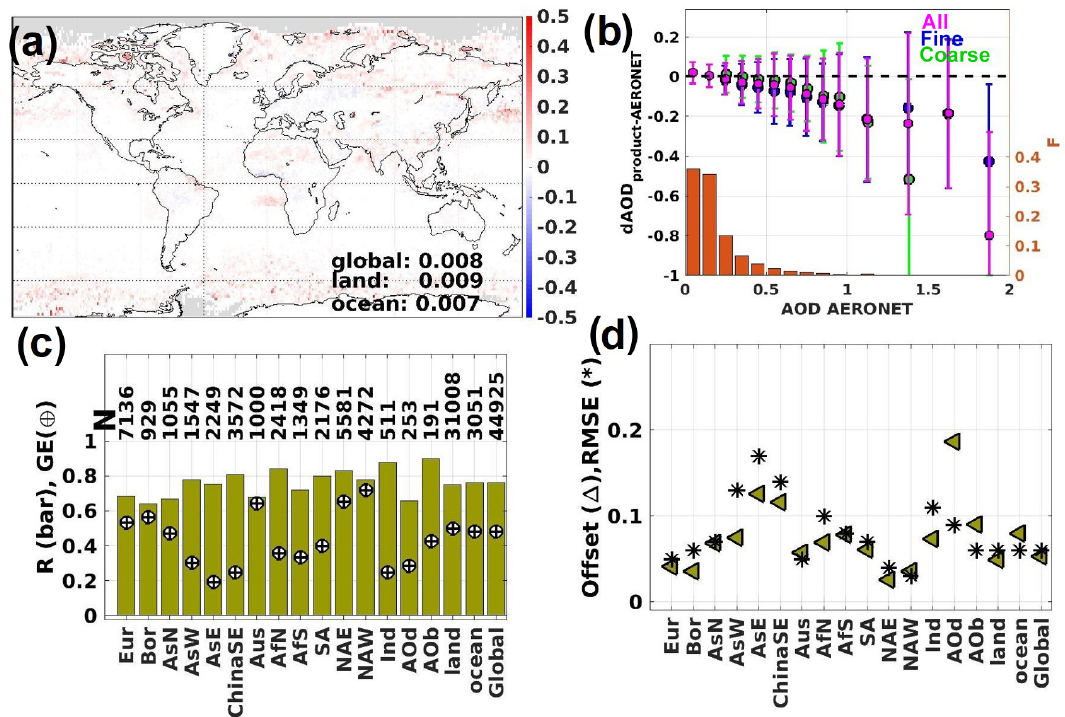
Figure 9. (a) L3 merged (approach 2 with RM2 for all) AOD product deviation from the annual median AOD calculated from individual products used for merging (Table 2) for the year 2008 (as Fig. S1 for individual products), (b) L3 monthly merged AOD product evaluation with AERONET: binned AOD bias for all (purple; background (AOD < 0 . 2; purple), fine-dominated (blue) and coarse-dominated (green) aerosol types. (c,d) Regional statistics ( c : correlation coefficient R , bar, and fraction of pixels that fulfil the GCOS requirements, GE, circle; d : offset, (cid:49) ; RMSE,